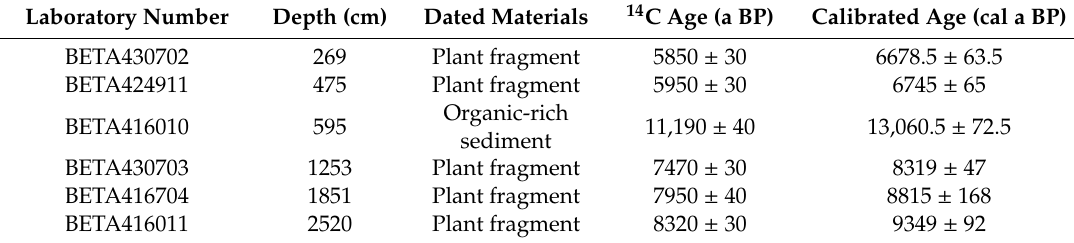
Table 2. AMS 14 C ages of core XH-2